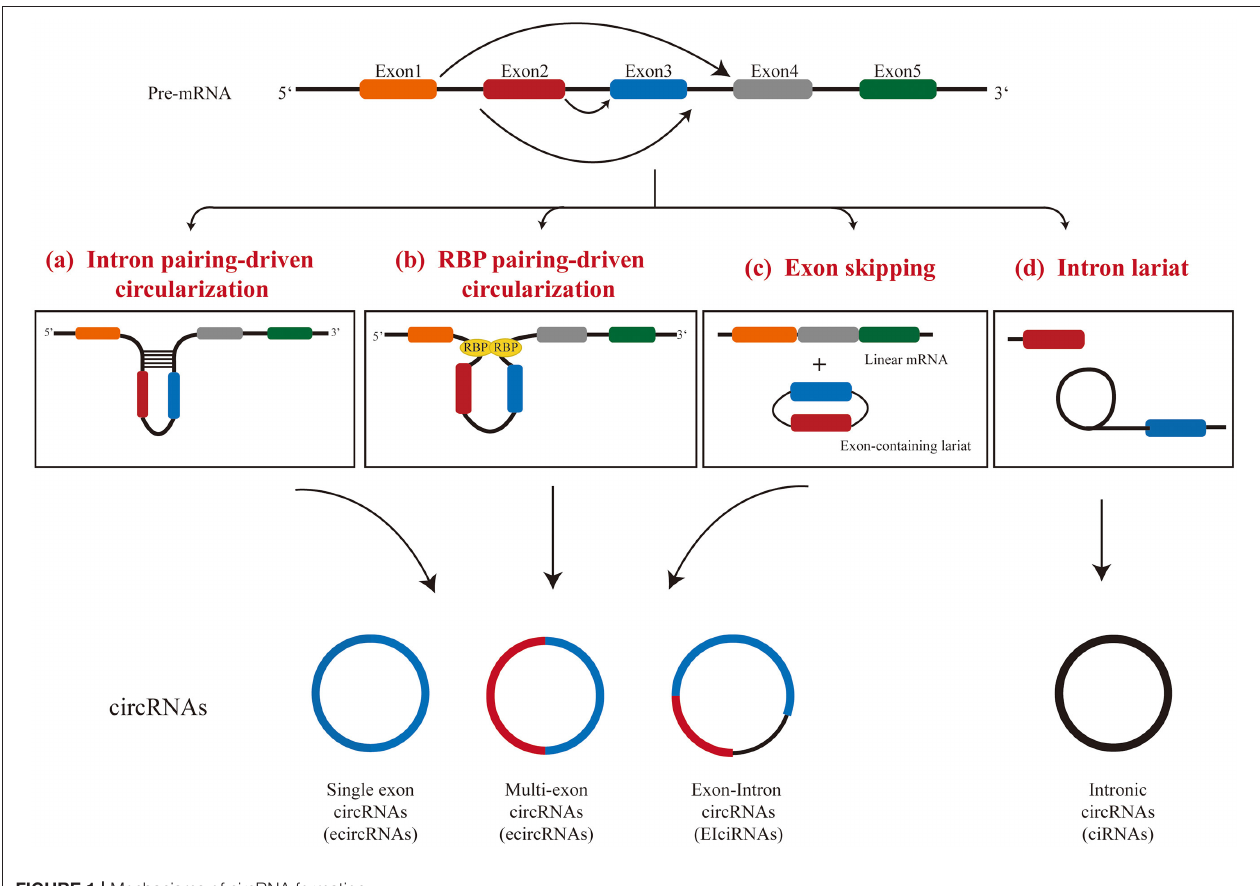
FIGURE 1 | Mechanisms of circRNA